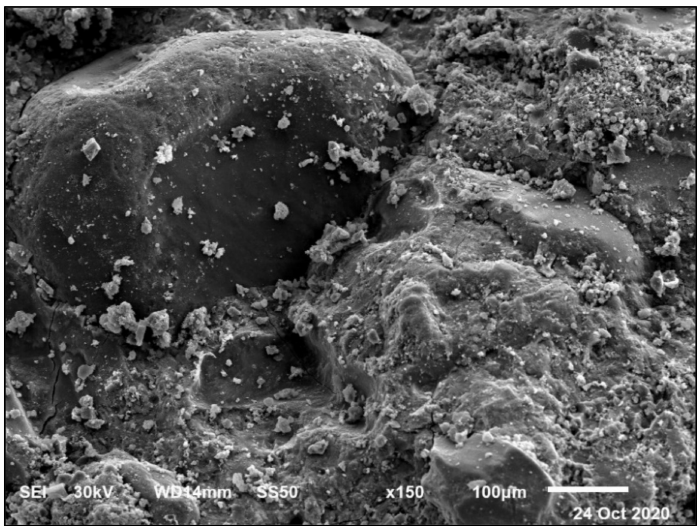
Figure 28. SEM of mix Z1 under sulfate exposure at 180 days at a scale of 100 µ